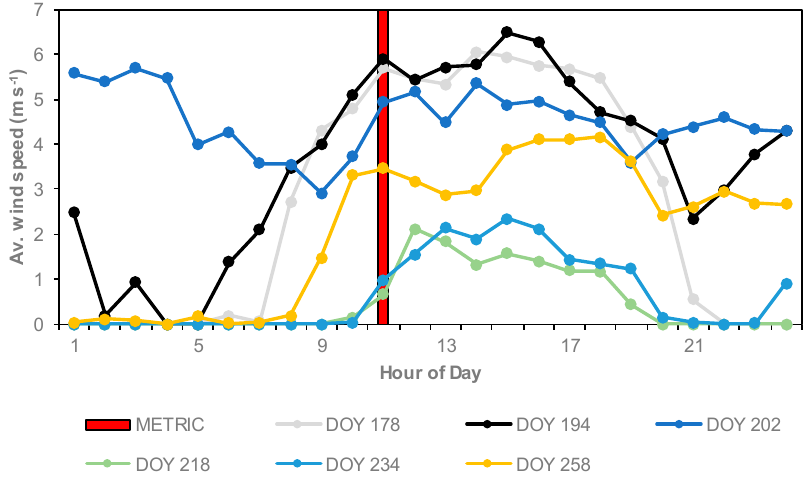
Figure 15. Hourly average wind speed values at the Brookings weather station for days at the satellite overpass. The red column represents the time of satellite overpass (METRIC) (~11:12 a.m.).